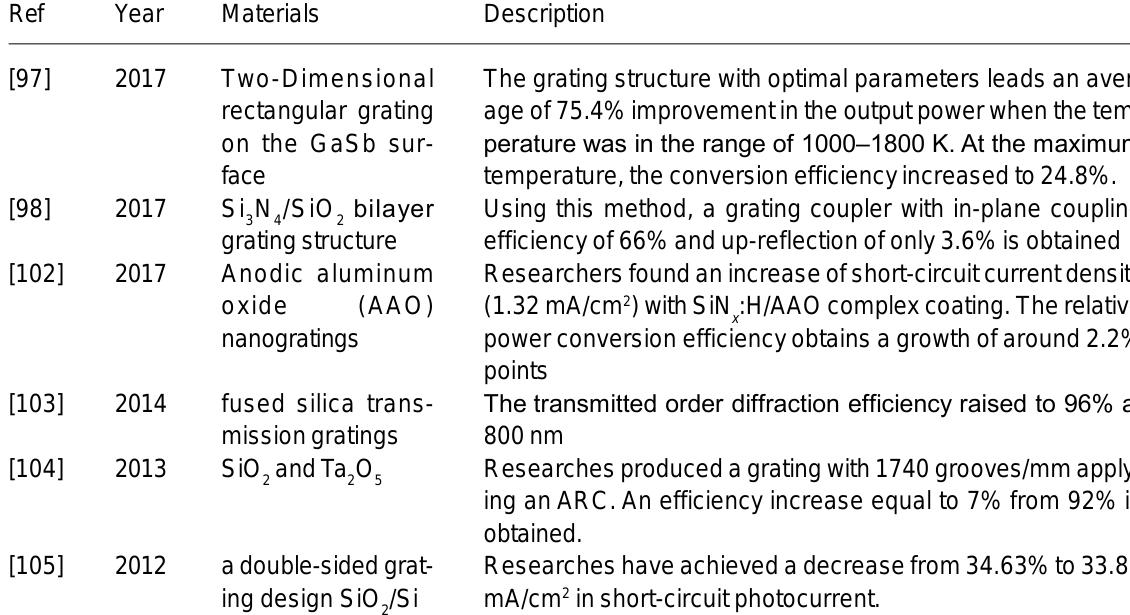
Table 5. A summary of some grating ARC